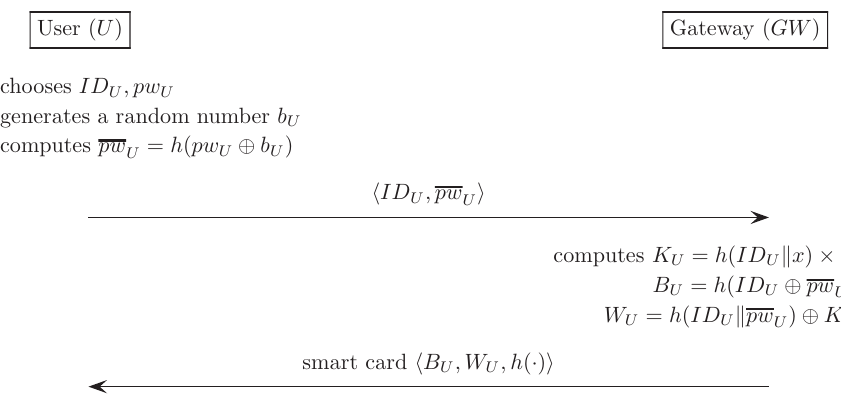
Figure 1. The registration phase of Shi et al .’s protocol.